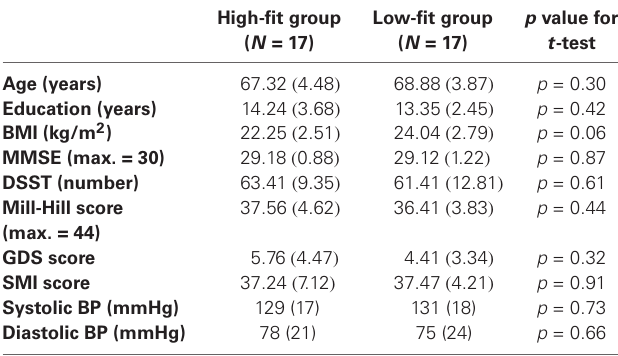
67.3% of the NIRS signals were characterized by activation